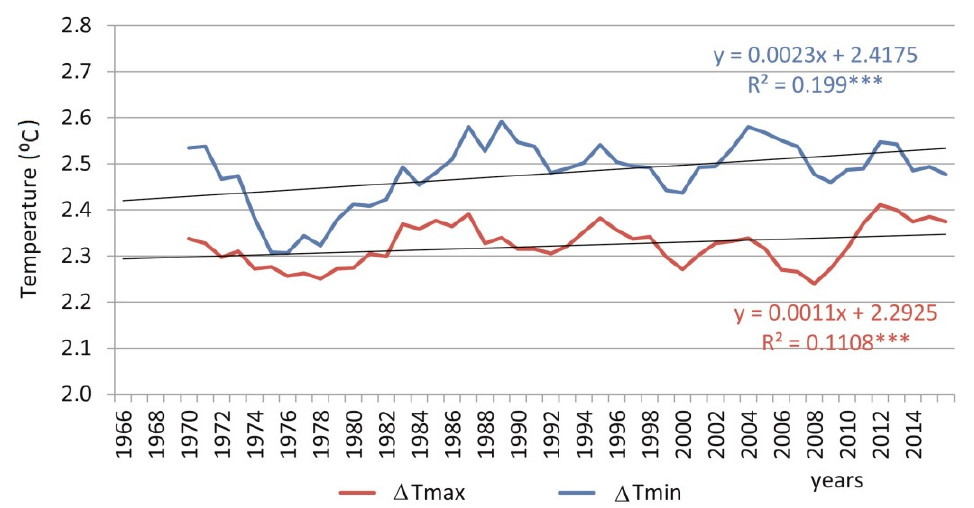
Figure 2. Average annual day-to-day changes of Tmax ( a ) and Tmin ( b ) in Poland in the years 1966–2015.